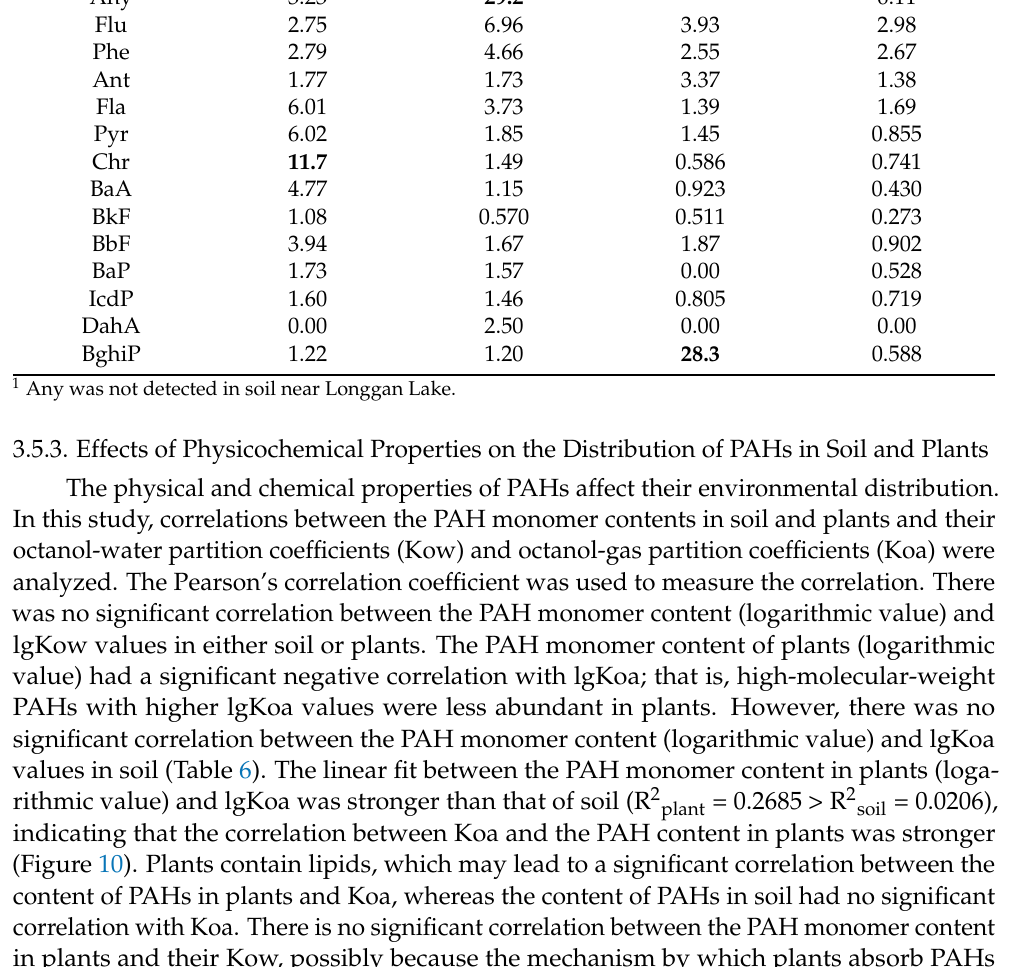
Table 5. Values of plant concentration factor (PCF) of PAHs in Zea mays L. (corn), Bidens pilosa L. and Gaillardia pulchella Foug. Plant Concentration Factor (PCF) Gaillardia Corn near Corn near Bidens pilosa L. pulchella Foug. Longgan Lake